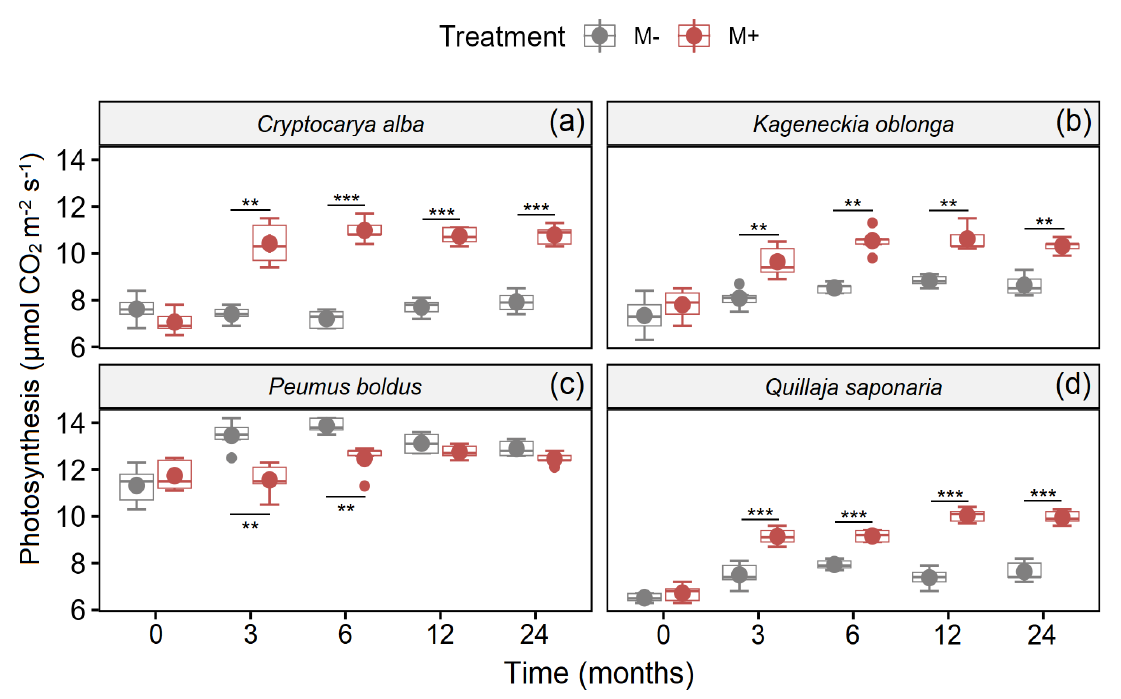
Figure 2. Photosynthesis in C. alba ( a ), K. angustifolia ( b ), P. boldus ( c ), and Q. saponaria ( d ), four dominant woody plant species from the Chilean Mediterranean ecosystem (MTE), after a fire with (red boxes) and without (grey boxes) inoculation with AMF. Values represent means (±1SE). Significant differences (pairwise t -test; Bonferroni correction) between treatments in all times measured are represented with ** p < 0.01; *** p < 0.001. Table 3. Results of two-way repeated measures ANOVA on enzymes for the four tree species. Main factors: Time, AMF treatments, and their interaction. Degrees of freedom (d.f.), F-values, and p -values are